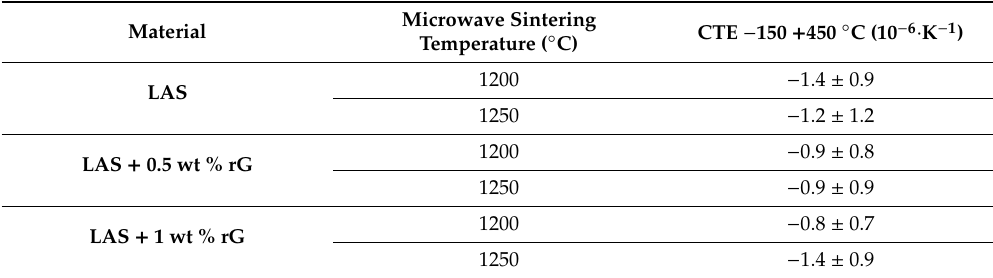
Table 3. Coe ffi cient of thermal expansion of LAS and LAS-rG materials.